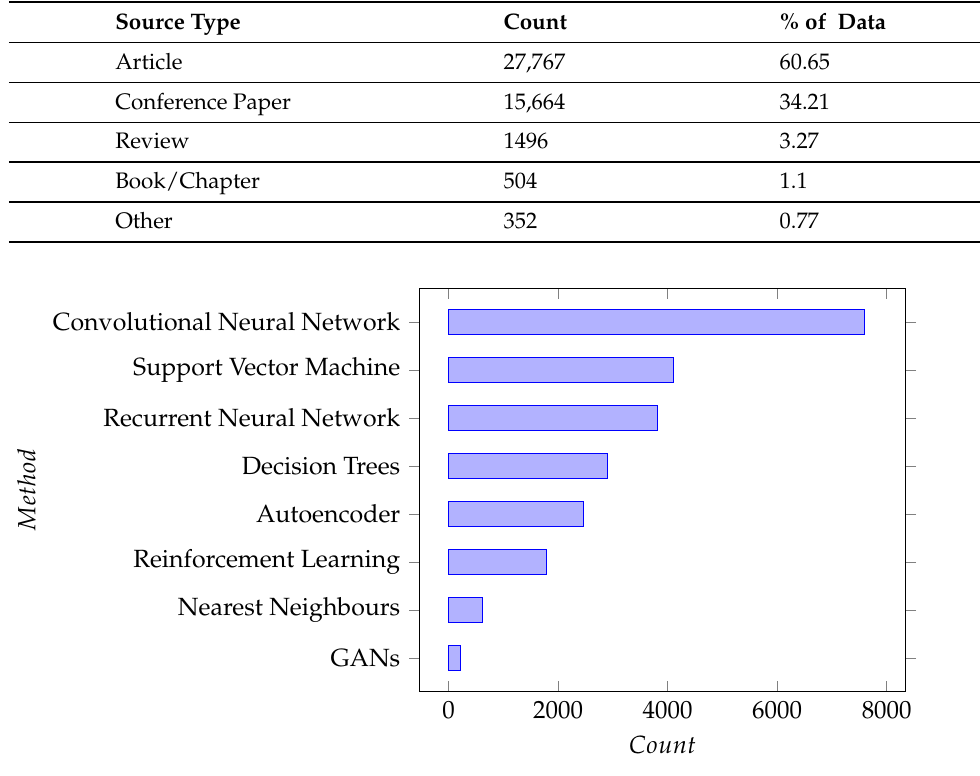
Figure 4. ML Methods by paper count for corpus.